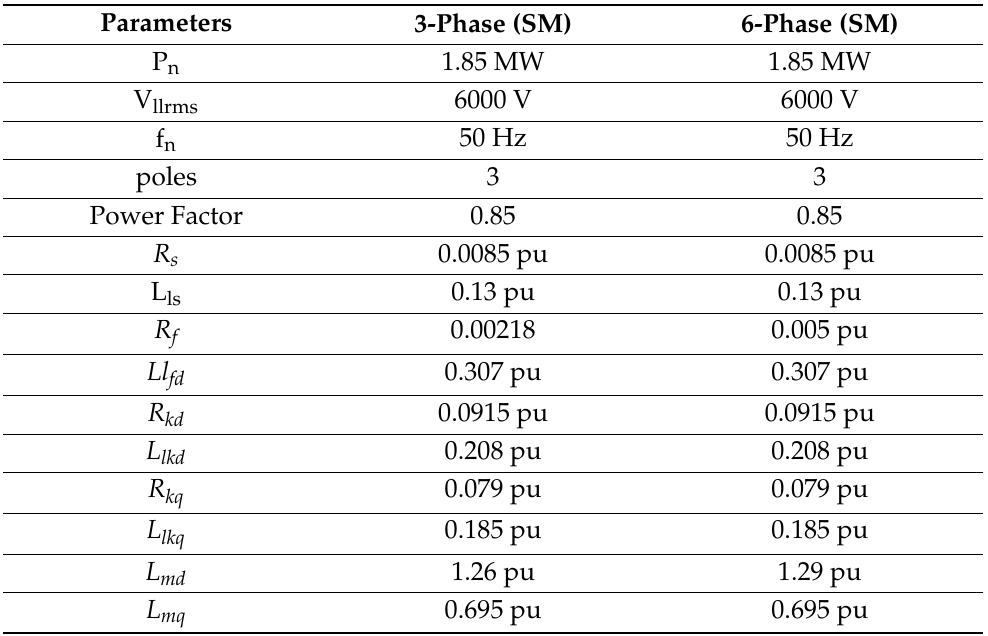
Table 1. Simulation